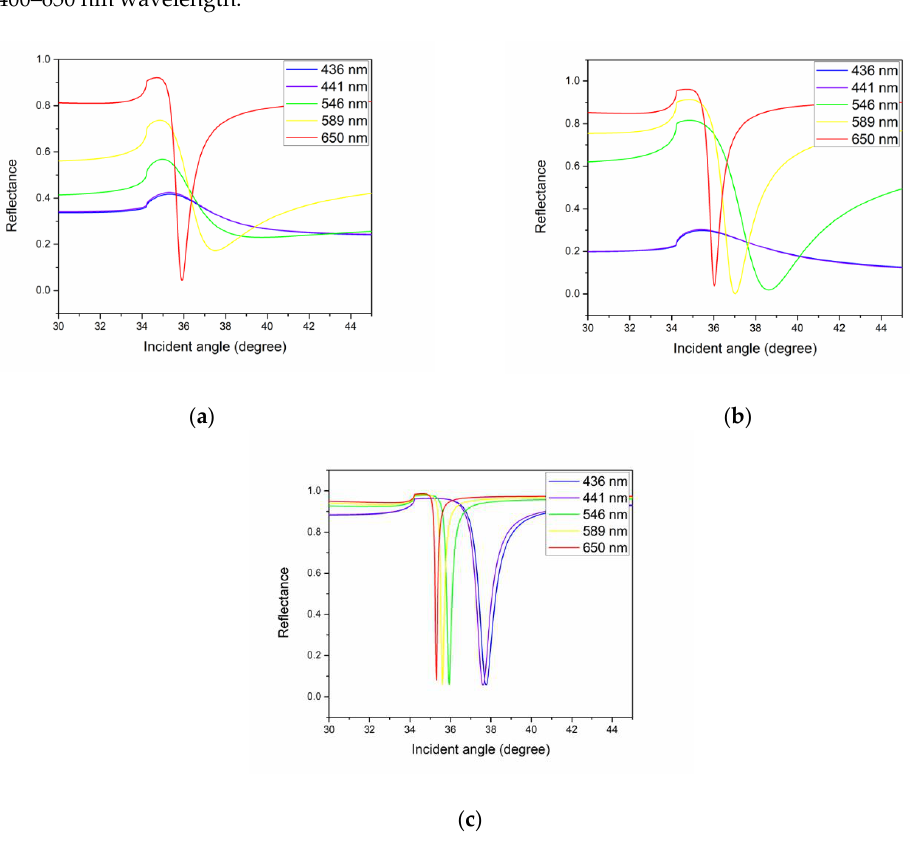
Figure 4. SPR signal using different excitation wavelength for ( a ) copper, ( b ) gold, and ( c ) silver (thickness of 50 nm) in contact with air.